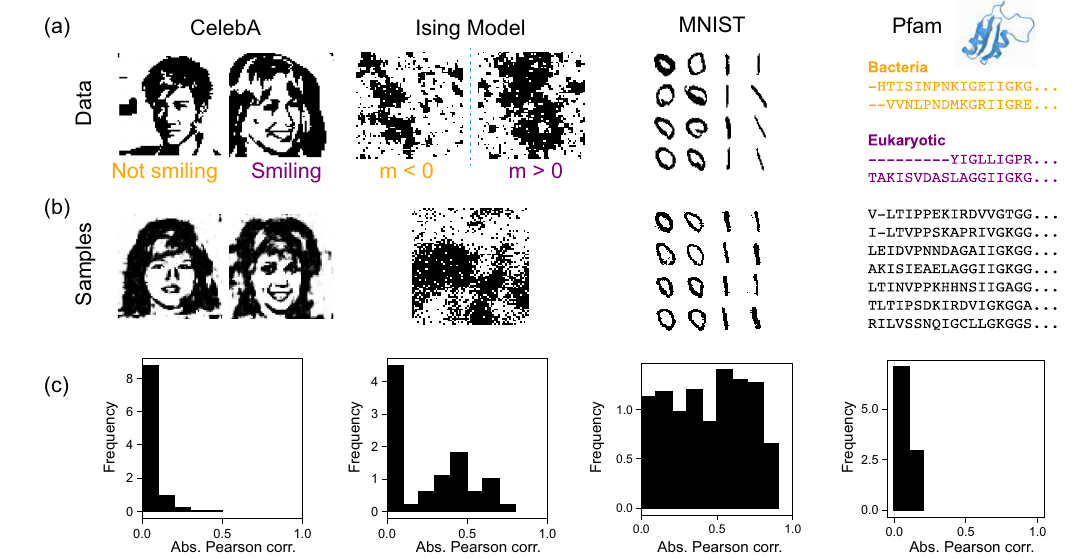
FIG. 2. Datasets considered in the paper and entanglement of representations. (a) CelebA dataset of face images [23]; two-dimensional Ising model; MNIST 0 = 1 database of handwritten digits [24]; multiple sequence alignments from the Pfam PF00013 family of the KH domain. (b) Samples generated by different RBMs trained on each dataset. See Supplemental Material [26] Appendix A 6 for the architectures of the RBMs used in each case. (c) Histogram of the absolute value of the Pearson correlations between hidden-unit inputs and the chosen label; see Eq. (5). Smiling or not smiling for CelebA, sign of the magnetization for the Ising model, whether the digit is a 0 or 1 for MNIST 0 = 1 , and whether the KH sequence is from bacterial or eukaryotic